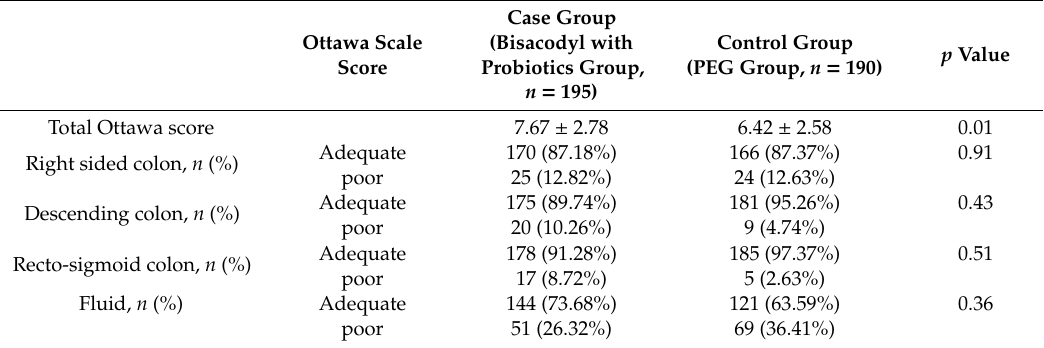
Table 2. Comparisons of the e ffi cacies of bowel preparation agents according to the bowel segments between groups using the Ottawa bowel preparation scale.